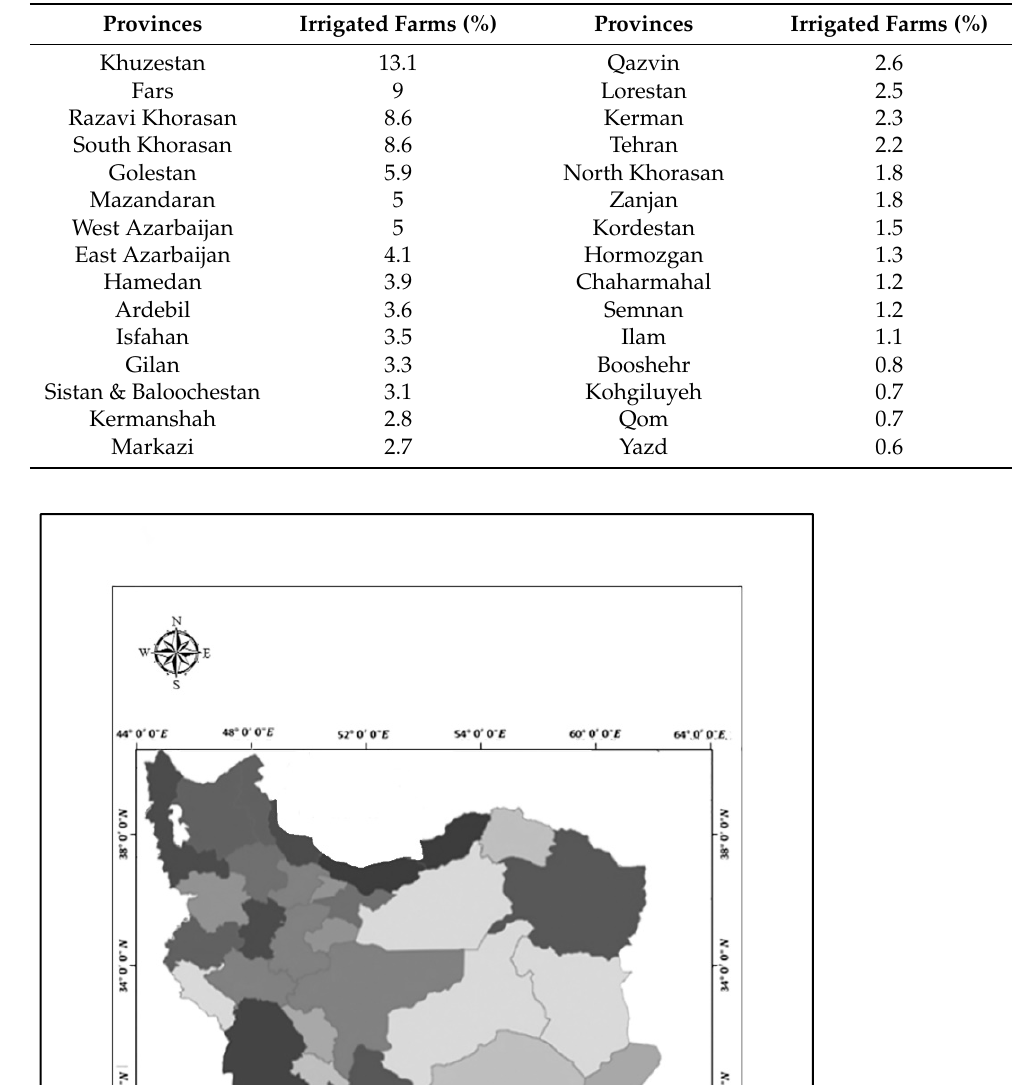
Table 7. Percentage of irrigated farms in Iranian provinces ( Ministry of Agriculture –2016).